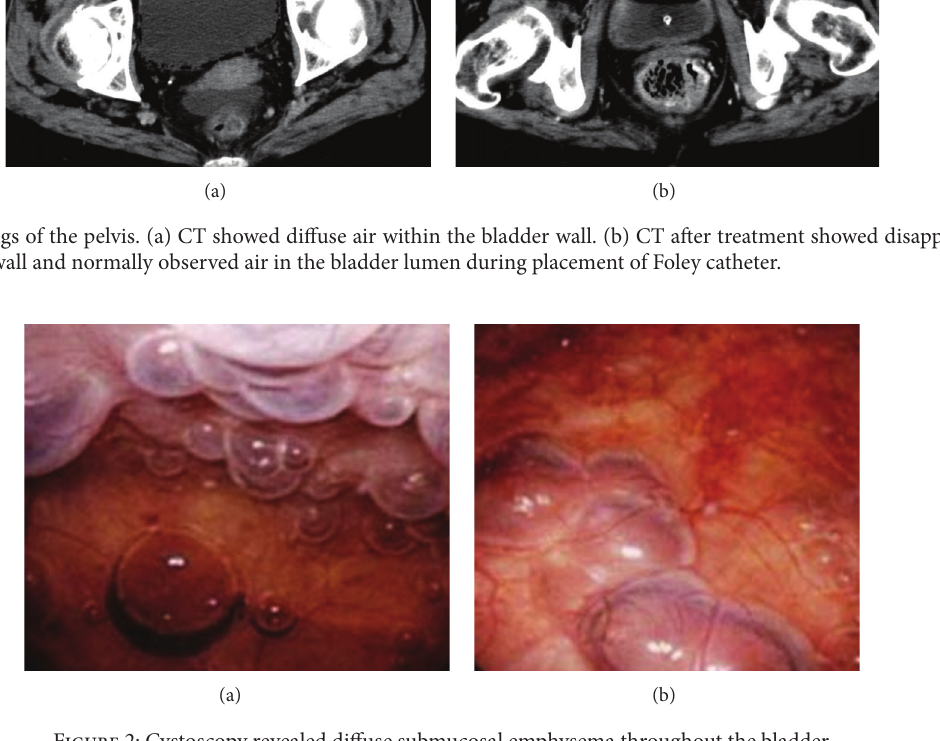
Figure 2: Cystoscopy revealed diffuse submucosal emphysema throughout the